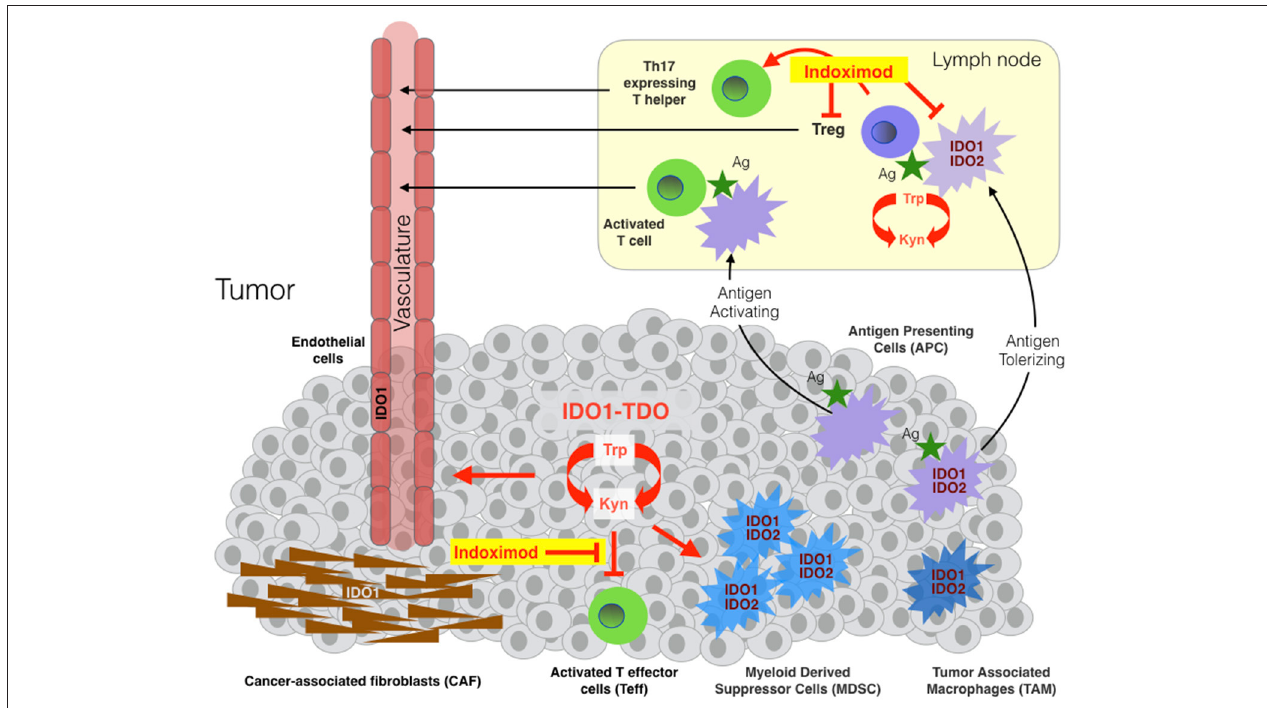
FIGURE 1 | Sites of indoximod action in cancer . IDO1, TDO, and IDO2 are expressed variously in malignant, immune, stromal and vascular cells in the tumor microenvironment and in antigen-presenting cells (APC) of tumor-draining lymph nodes. TDO and IDO2 are relatively more narrowly expressed than IDO1 in human cancers, with TDO overexpressed in some tumors independently or in parallel with IDO1 and IDO2 expressed in antigen-presenting cells including B cells where it may influence IDO1 function (28). Tryptophan catabolism in tumor cells leads to locoregional generation of kynurenine at the cost of tryptophan, enabling suppression of local T effector cells (Teff), licensing and recruitment of myeloid-derived suppressor cells (MDSC) and support of a tumor-enabling vasculature. The tumor microenvironment variously recruits cancer-associated fibroblasts, vascular endothelial and inflammatory myeloid cells that express IDO1 and/or IDO2. Tumor antigens absorbed by IDO1/IDO2-expressing antigen-presenting cells (APC) rove to draining lymph nodes where they promote the formation and activation of T regulatory cells (Tregs). Studies suggest that indoximod enables Teff in tumors and attenuate in draining lymph nodes, in the latter case by acting on dendritic cells leading to suppression and/or reprogramming of Tregs and the formation of Th17-expressing T helper cells.